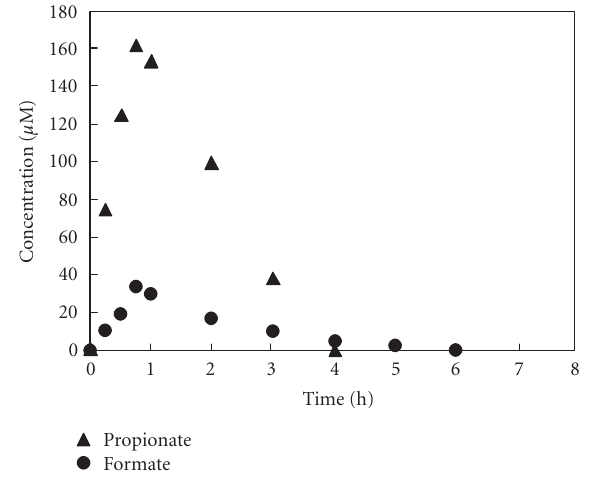
Figure 6: Time evolution of the inorganic ionic species formed dur- ing the photocatalytic degradation of a 20mg L − 1 aqueous solution of